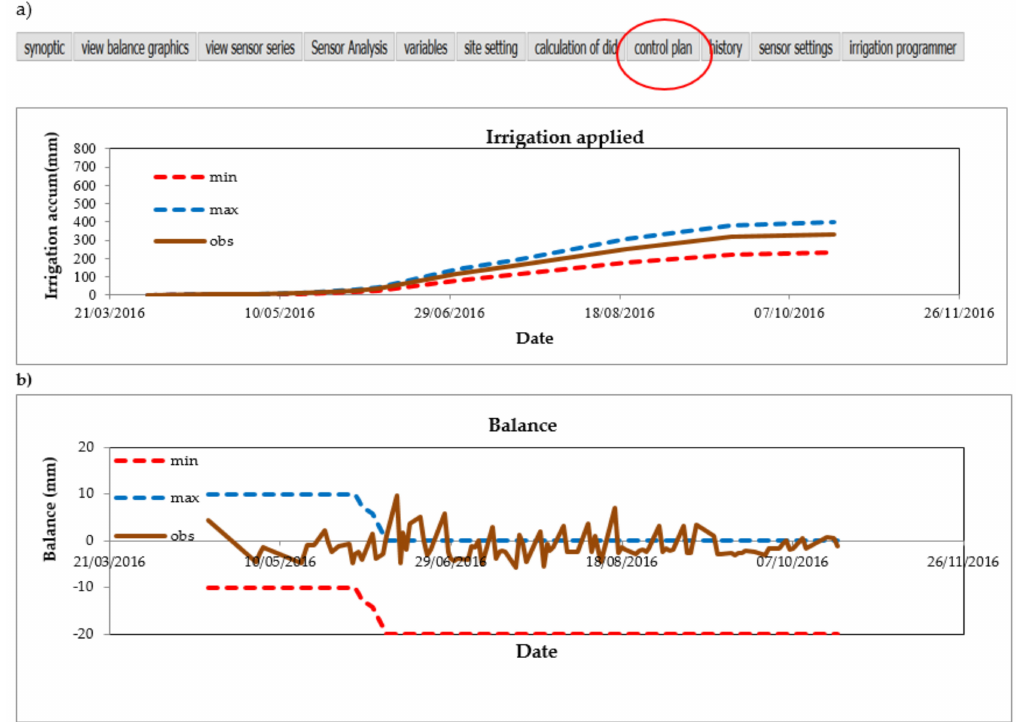
Figure 4. Screenshot of the ‘control plan’ tab of IRRIX in the year 2016, ( a ) the accumulated irrigation of treatment A during the irrigation campaign and ( b ) the water balance of treatment A during the irrigation